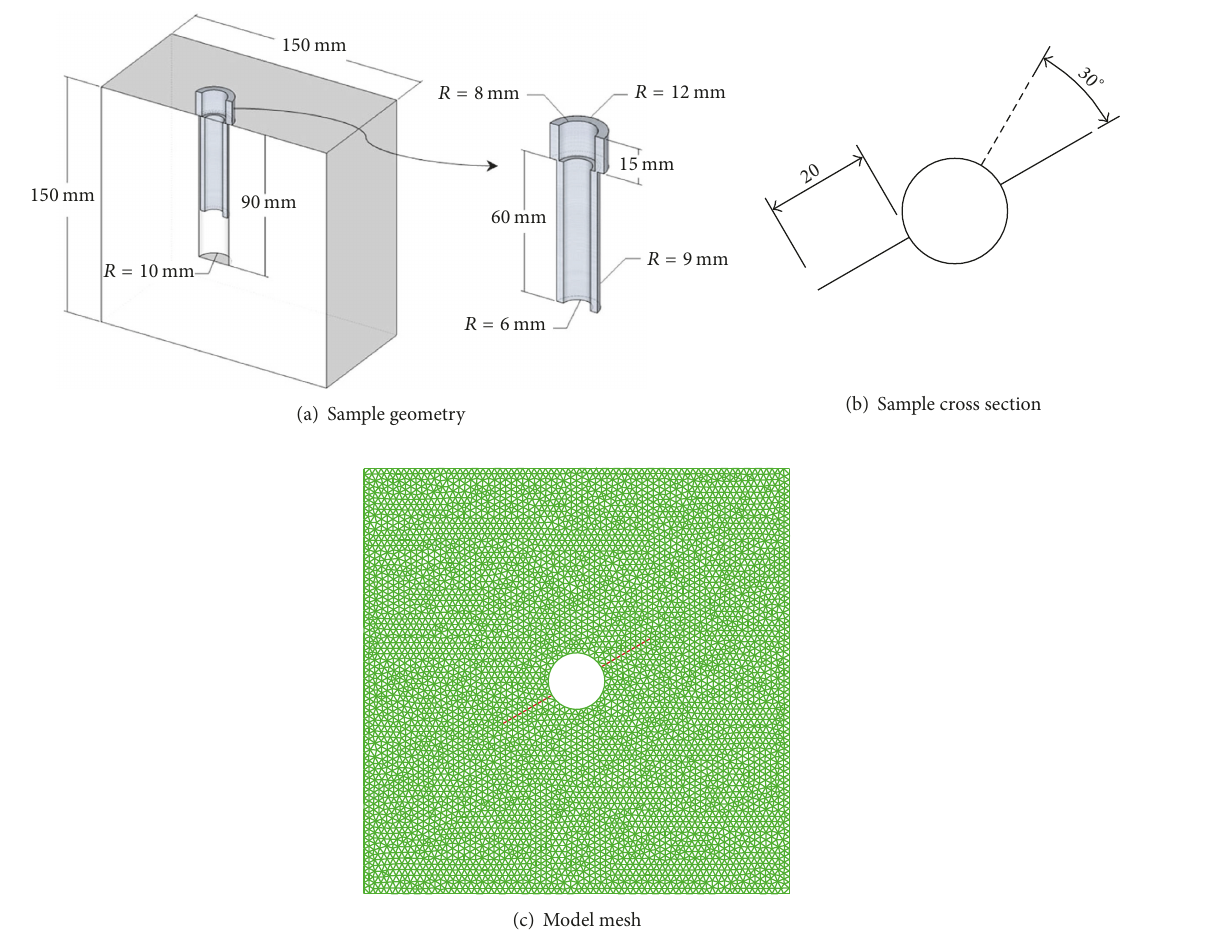
Figure 15: A cubic specimen with preset fractures.